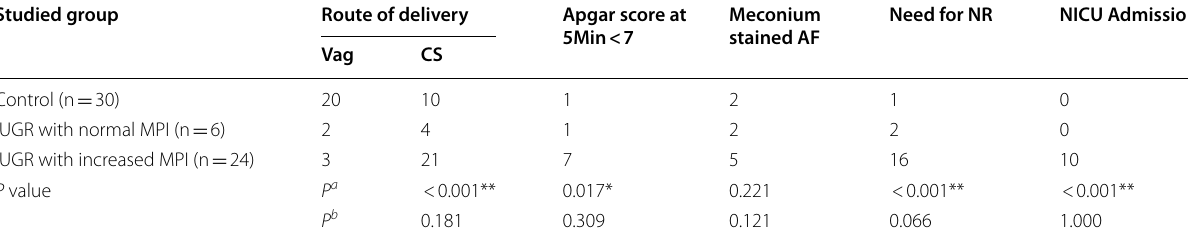
FE Fisher’s Exact, S.AF amniotic fluid, NR neonatal resuscitation, NICU neonatal intensive care unit * p value < 0.05